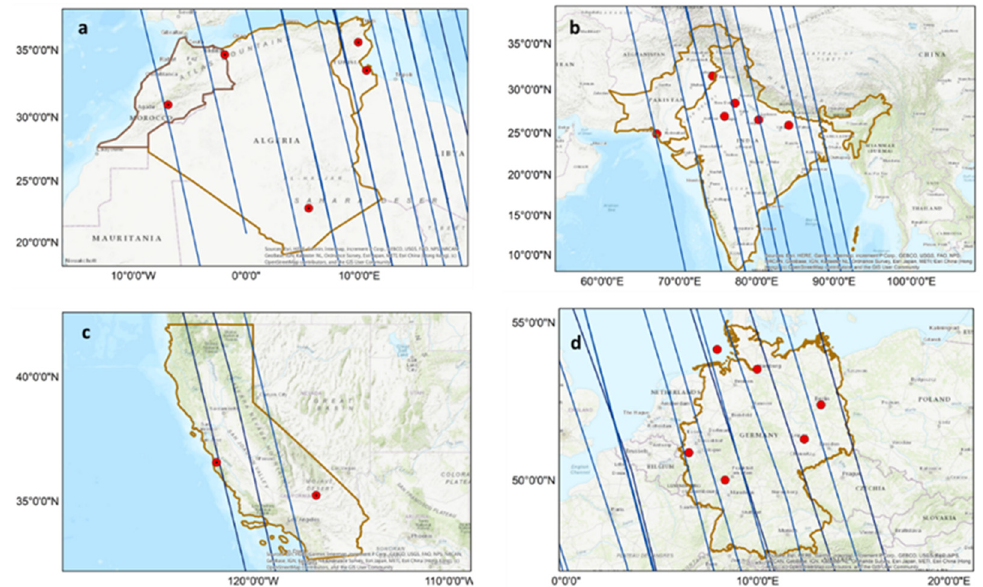
Figure 1. The geographic distribution of the AERONET stations (red dots) across the study areas (( a )—North Africa, ( b )—South Asia, ( c )—California, and ( d )—Germany). The blue lines are the CALIPSO paths over the study areas.